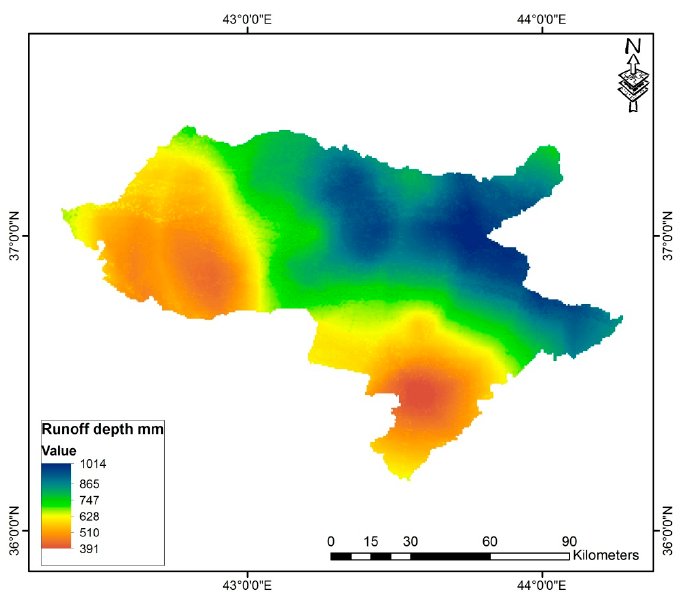
Figure 4. Runoff depth potential map for the study area. Figure 4. Runo ff depth potential map for the study